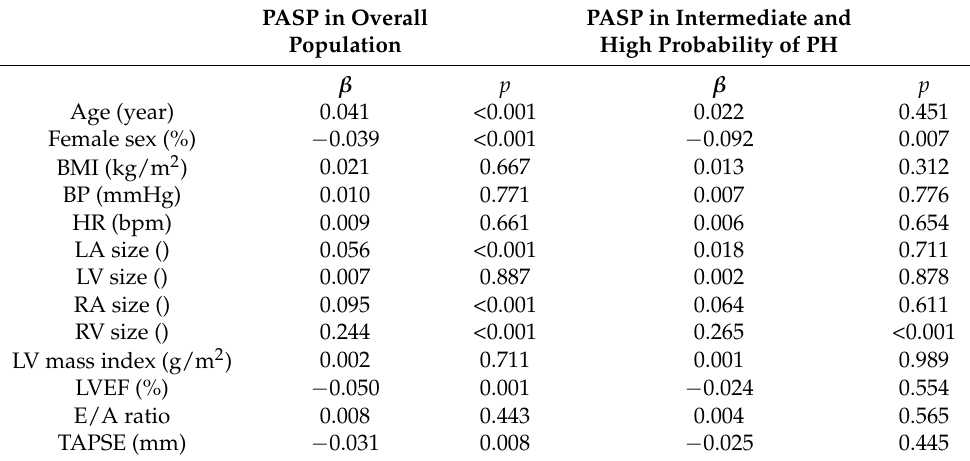
Table 3. Predictors of PASP in the multivariate analysis. PASP in